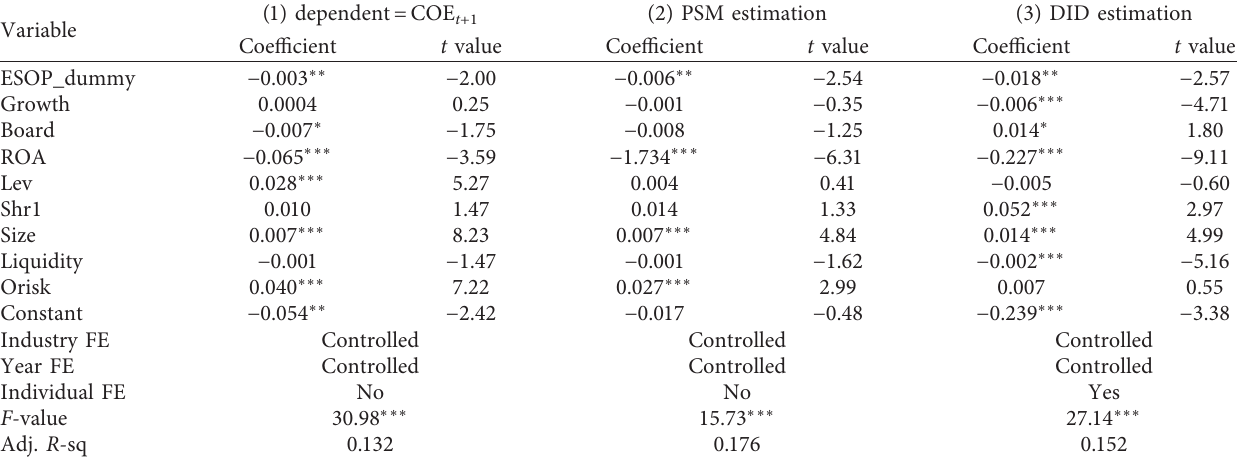
Table 6: Endogeneity test results.